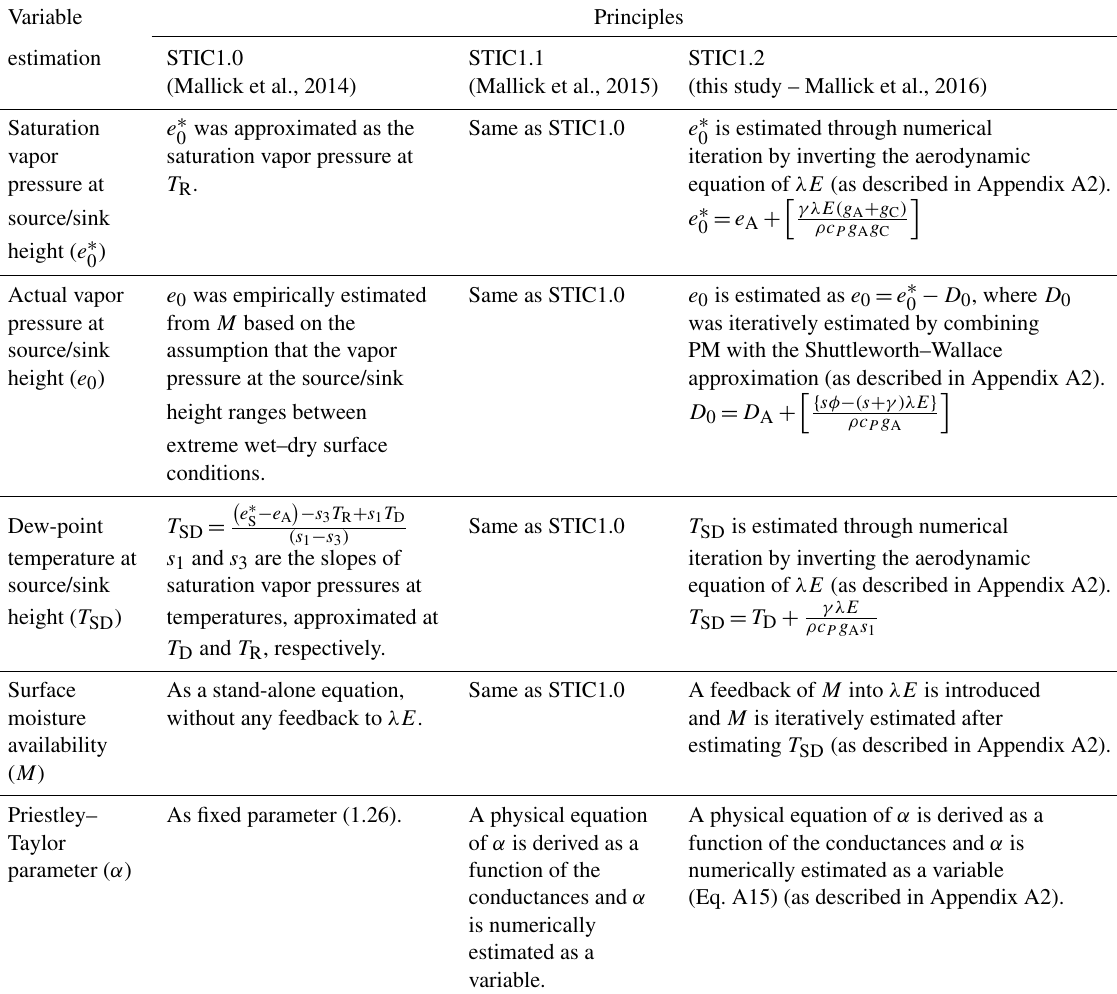
Table A1. Differences in the modeling philosophies of source/sink height vapor pressures ( e 0 , e ∗ wetness ( M ), and α between STIC1.0, STIC1.1, and